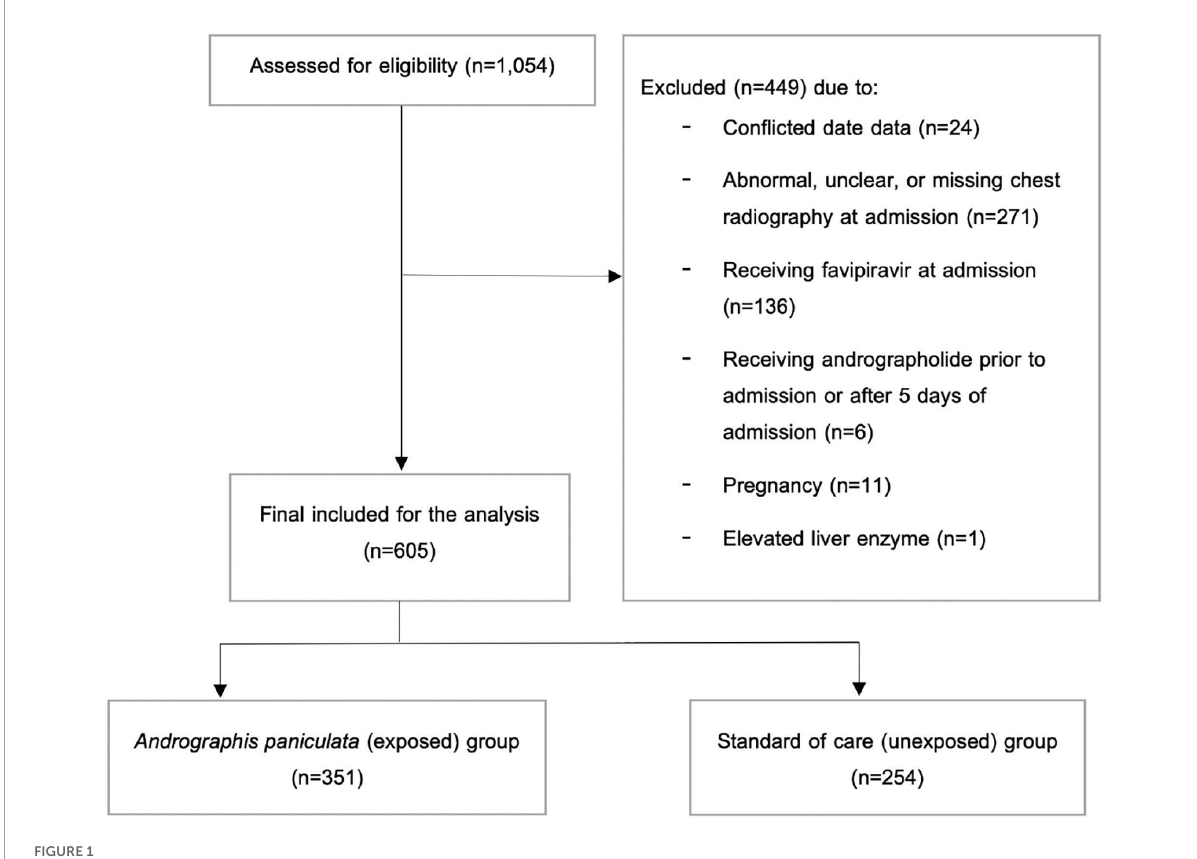
FIGURE1 Patient flow